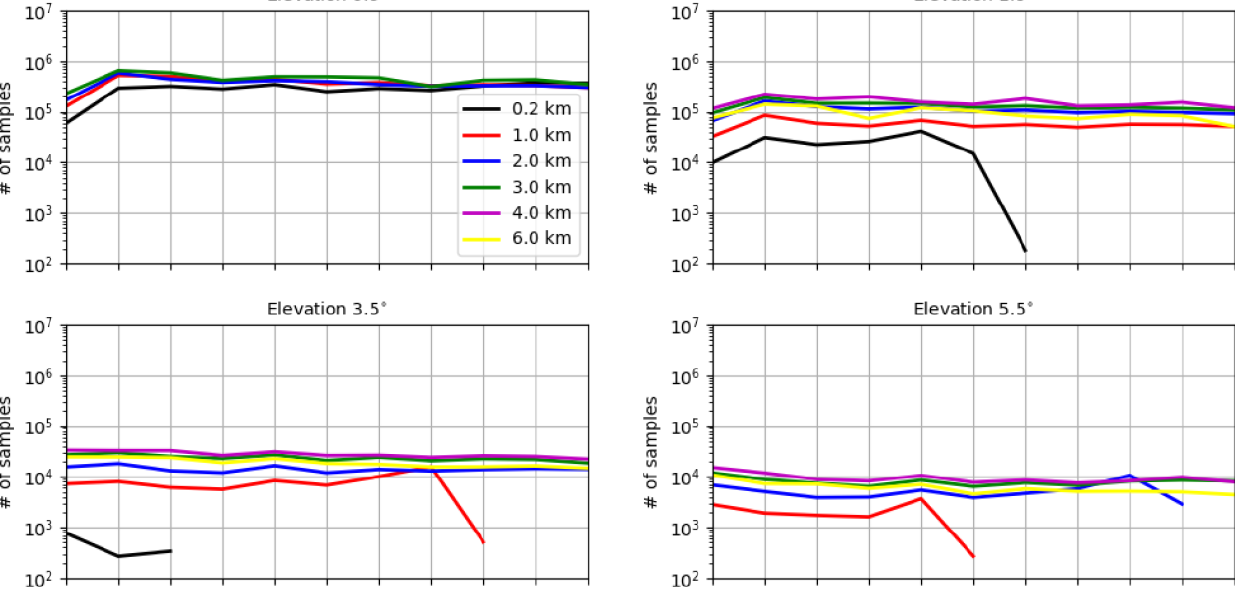
Figure A7. The numbers of samples used for estimating horizontal correlations for the OE of reflectivity data ≥ 5dBZ for elevations of 0 . 5,